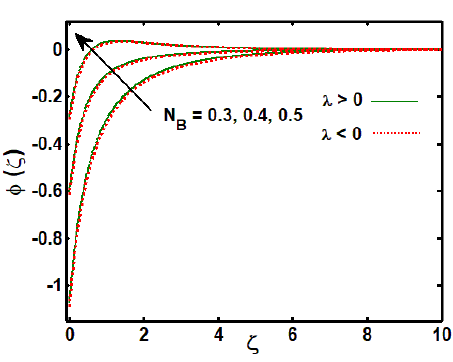
Figure 17. E ff ects of N B on the φ ( ζ ) Figure 17. Effects of 𝑵 𝑩 on the 𝝓(𝜻) . Figure 17. Effects of 𝑵 𝑩 on the 𝝓(𝜻) .